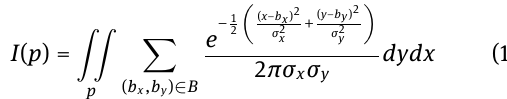
Classification of textures by topological landscapes. Proportion of positives in each class in